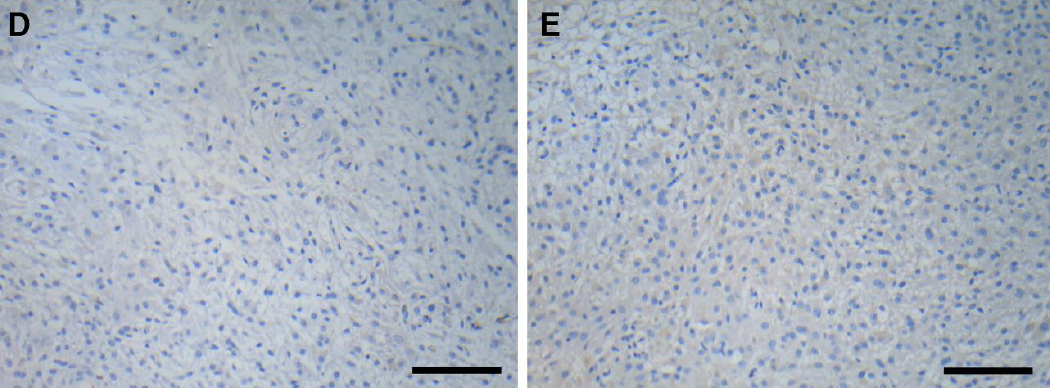
Figure 2. Immunohistochemistry of pleomorphic myxoid liposarcoma. The neoplastic cells were positive for ( A ) vimentin, and negative against ( B ) alpha-smooth muscle actin, ( C ) CD68, ( D ) desmin, and ( E ) S100. Scale bar = 200 μm.